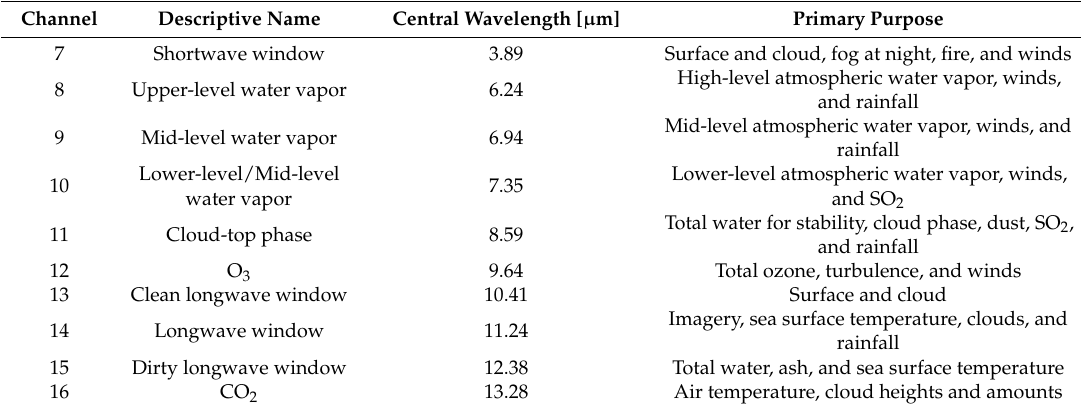
Table 1. Himawari-8 AHI channel-specific central wavelengths and primary